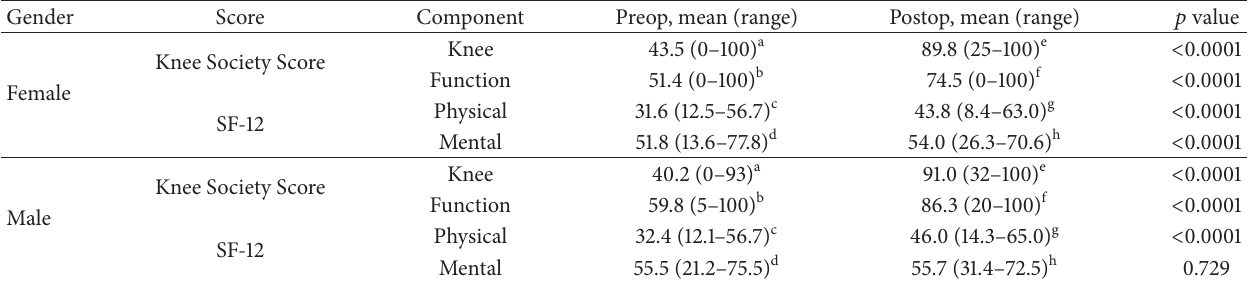
Table 2: Knee Society Score and SF-12 outcomes summaries after a minimum of 2 years.